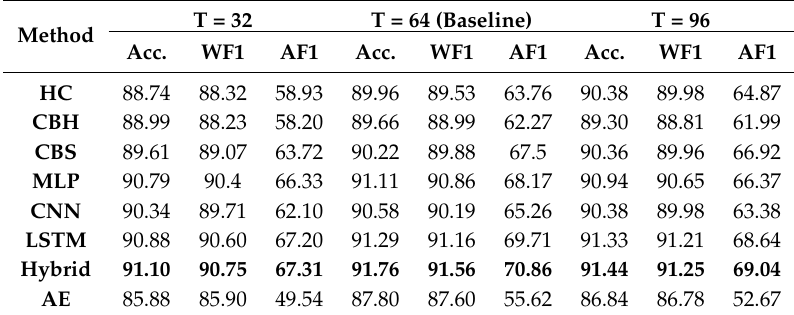
Table 7. Performance metrics (in percent) of different feature extraction models on the OPPORTUNITY dataset with different window sizes T .